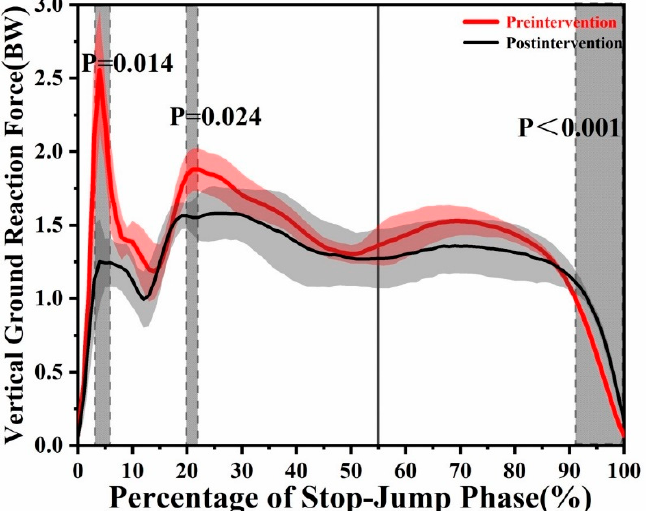
Figure 2. The results of statistical parametric mapping (SPM) pre- and post-video feedback depicting the mean of the vertical ground reaction force (vGRF). The solid line at 55% represents the time of maximum knee flexion. The grey region indicates a statistical difference ( p < 0.05).